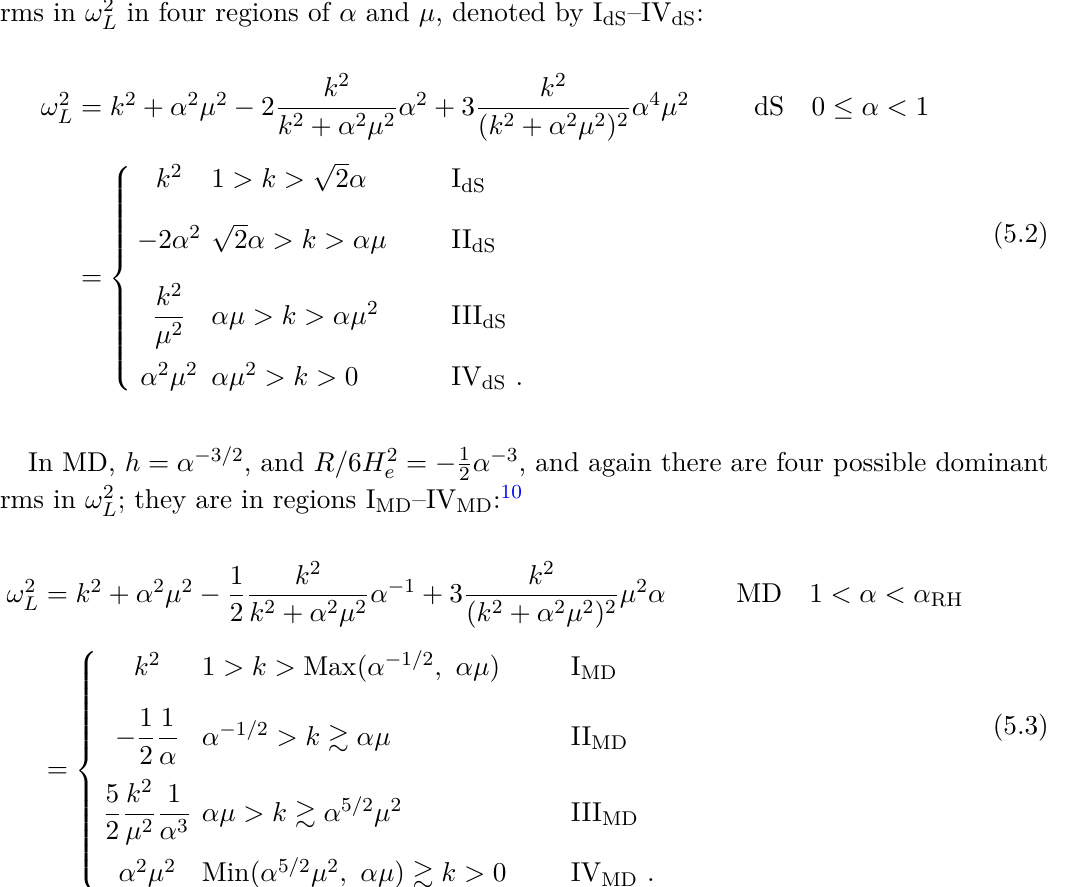
H 3 , n a 3 = n a 3 /a 3 H 3 , e e e e